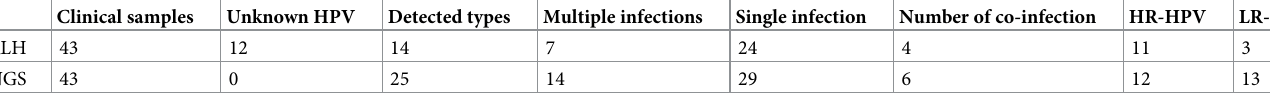
Table 2. Summary of the comparison between NGS and RLH genotyping assays. Clinical